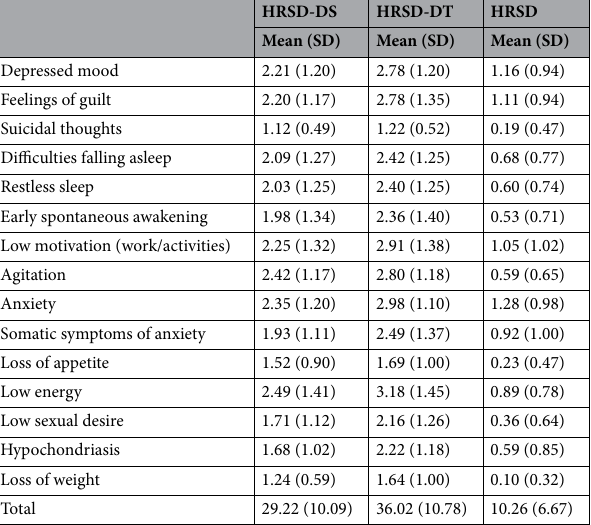
Table 2. Means scores and SD of the HRSD-DT HRSD-DS and HRSD. HRSD-D items scores range between 1 and 5, HRSD items scores range between 0 and 3.